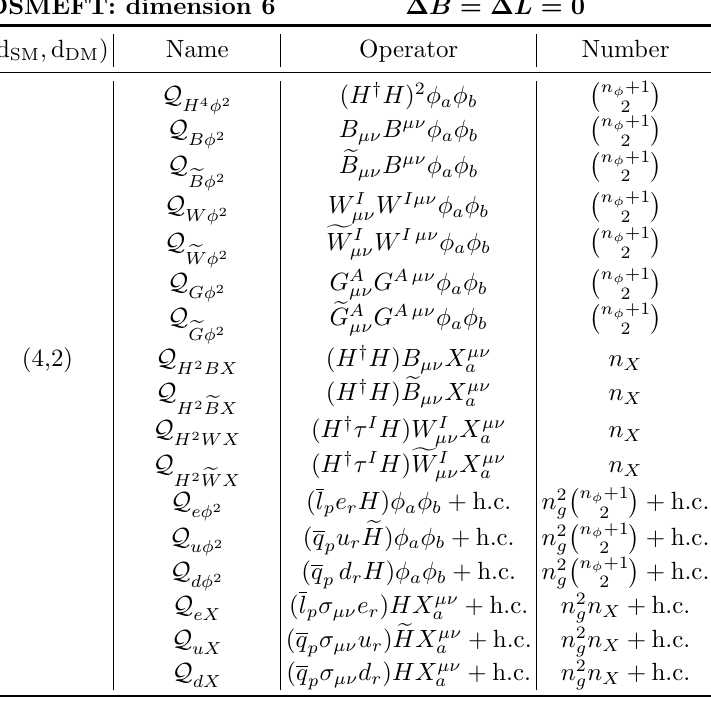
Table 12 . Dimension-six ∆ B = ∆ L = 0 operators in DSMEFT, part 2. The first column gives the dimensions of the SM and DM part of the operator, and the fourth column is the number of operators.